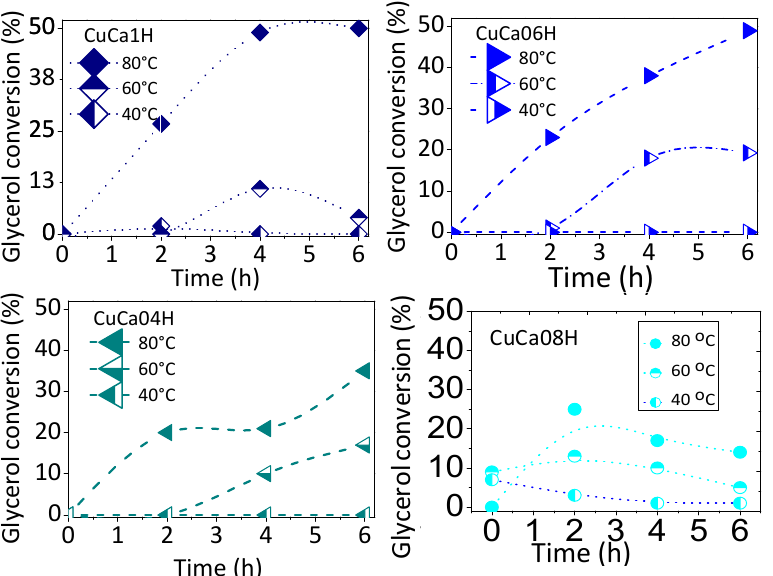
Figure 4. Time courses for glycerol conversion in the EG reaction over the most active catalysts. The reaction temperature was varied from 40 to 80 °C. Reaction conditions: 75 mg of catalyst with a glycerol to acetic acid molar ratio kept constant at 0.25.